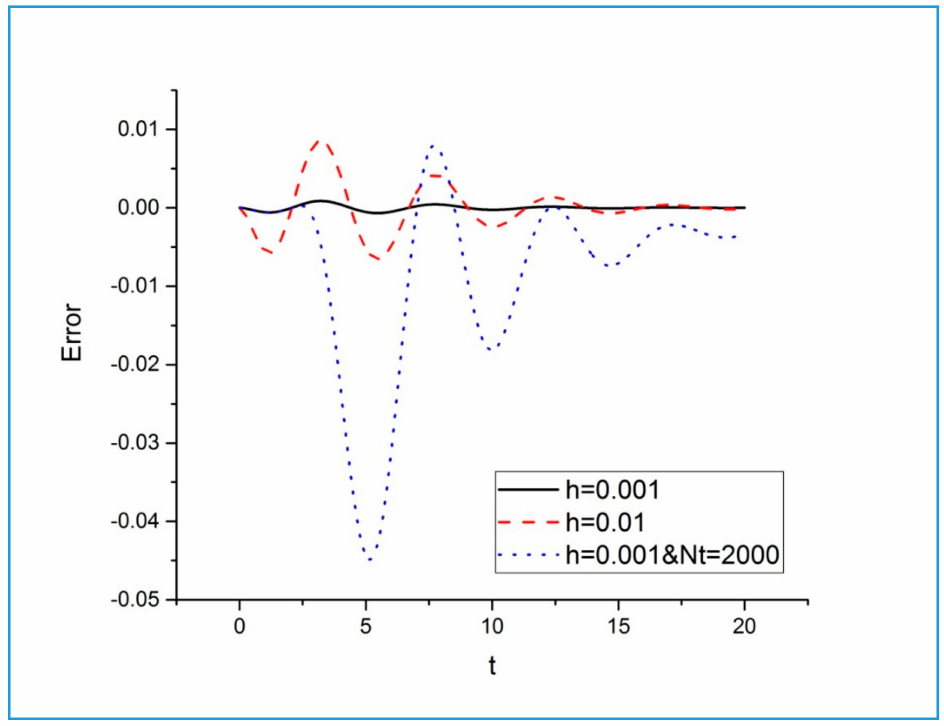
Figure 6. Errors between numerical solution (original definition method h = 0.01, 0.001 and SMP method h = 0.001 and Nt = 2000) and exact solution ( α =